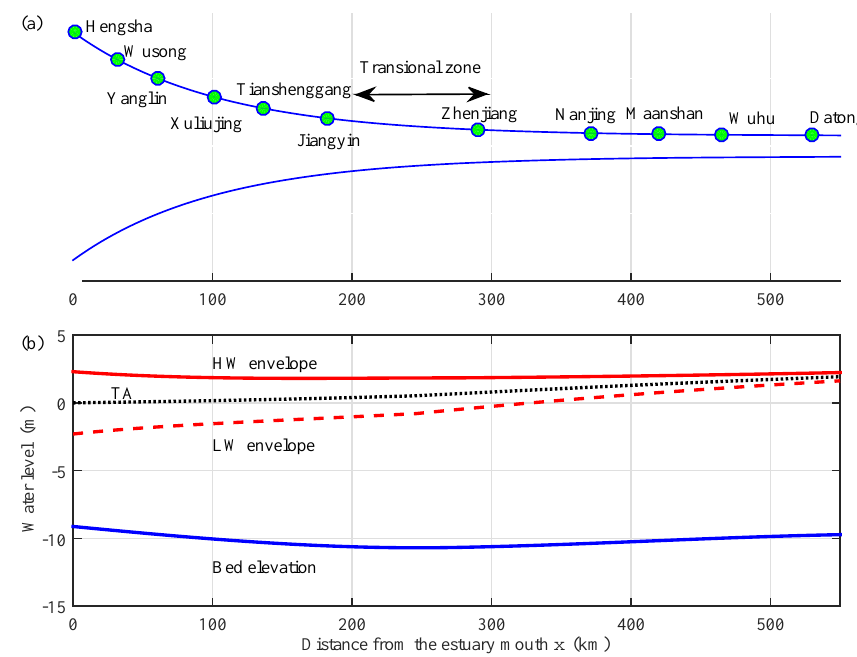
Figure 13. Shape of the Yangtze estuary (a) and the longitudinal computation of the high water (HW) and low water (LW) envelopes along the Yangtze estuary (b) for given values of η 0 = 2 . 3m, Q = 10000m 3 s − 1 . The TA curve marks tidal average values. Table 3. The return values of EHWL (m) at different positions along the Yangtze estuary. Return